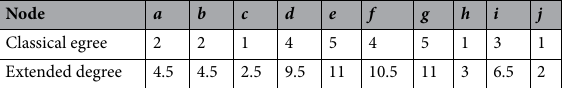
Table 1. The class degree and extended degree of each node in the simple network.